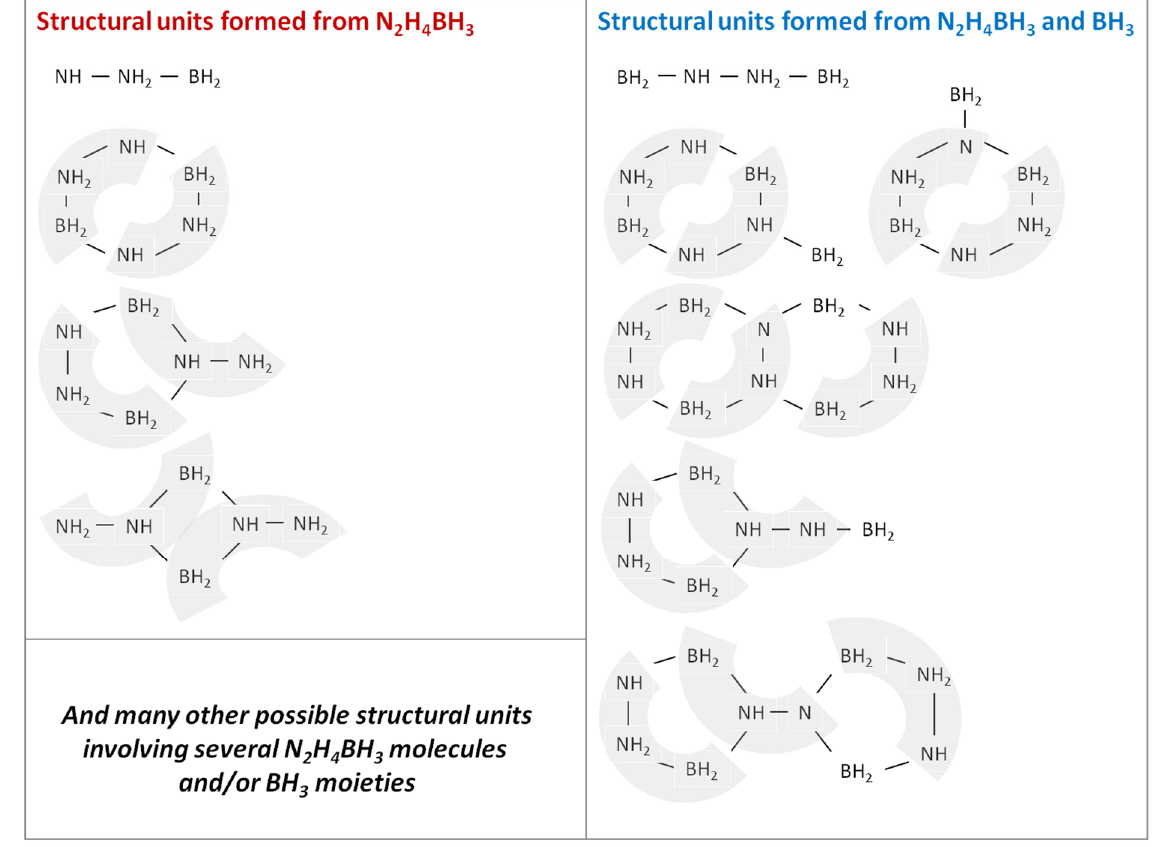
Figure 5. Examples of likely structural units of the solid by-products formed by the decomposition of hydrazine borane N 2 H 4 BH 3 over the range 25–200 °C [24]—reproduced by permission of the PCCP Owner